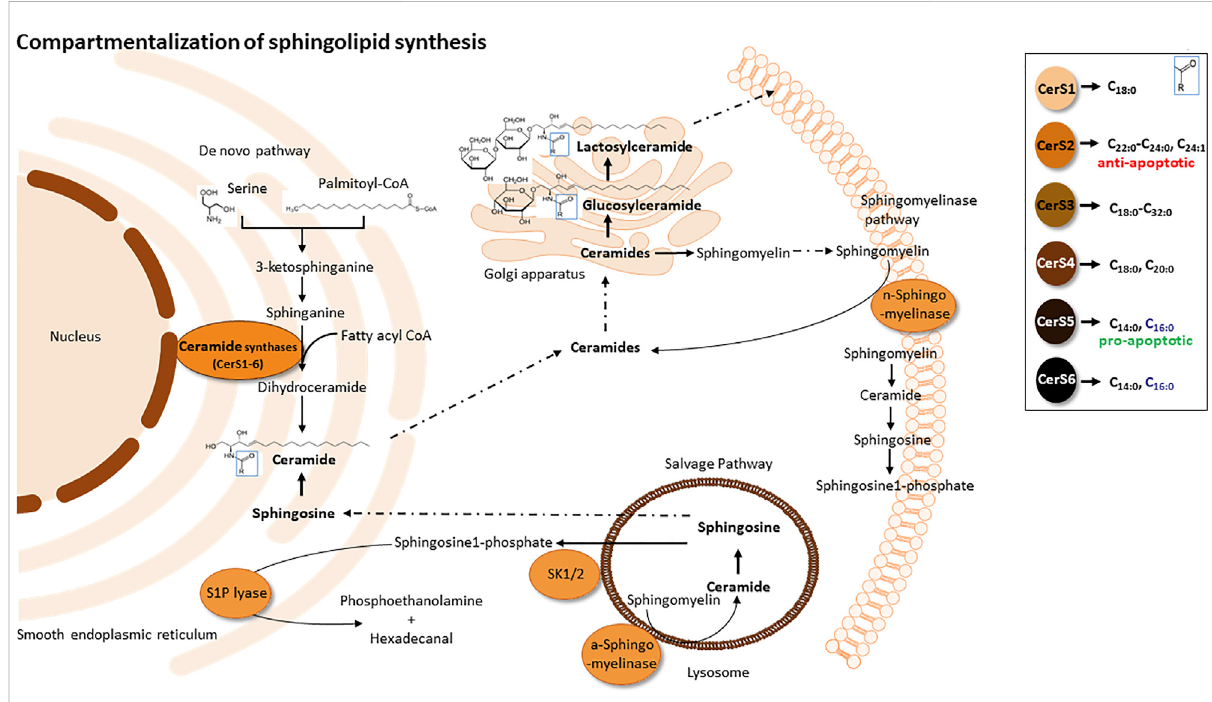
FIGURE 3 Compartmentalization of sphingolipid synthesis. De novo sphingolipid synthesis (anabolic pathway) is located at the smooth ER and ER- associated membranes - perinuclear membrane and mitochondria associated membranes (MAMs). Sphingolipid synthesis starts via the condensation of L-serine and palmitoyl co-enzyme A (CoA) to form 3-ketosphinganine by serine palmitoyltransferase. Subsequently, 3- ketosphinganine reductase reduces 3-ketosphinganine to sphinganine, which is acylated in order to from dihydroceramide by ceramide synthase. Dihydroceramide is afterwards oxidized by a desaturase, which results in ceramide formation. Ceramide is transported from the ER to the Golgi apparatus and is converted into sphingomyelin by sphingomyelin synthase or glycosphingolipids by ceramide glucosyltransferase. Sphingomyelin and complex glycosphingolipids synthesized in the Golgi apparatus are transported to the plasma membrane. Within the plasma membrane and other cell compartments, sphingomyelin are hydrolyzed by acid/neutral sphingomyelinases (SMases) to yield ceramide. Ceramide can be hydrolyzed by ceramideases (Cdases) to form sphingosine, which can be phosphorylated by sphingosine kinase (SphK) to generate sphingosine-1-phosphate (S1P). S1P can then be cleaved by S1P lyase to fatty aldehyde and phosphoethanolamine. Alternatively, S1P can be dephosphorylated back to sphingosine by